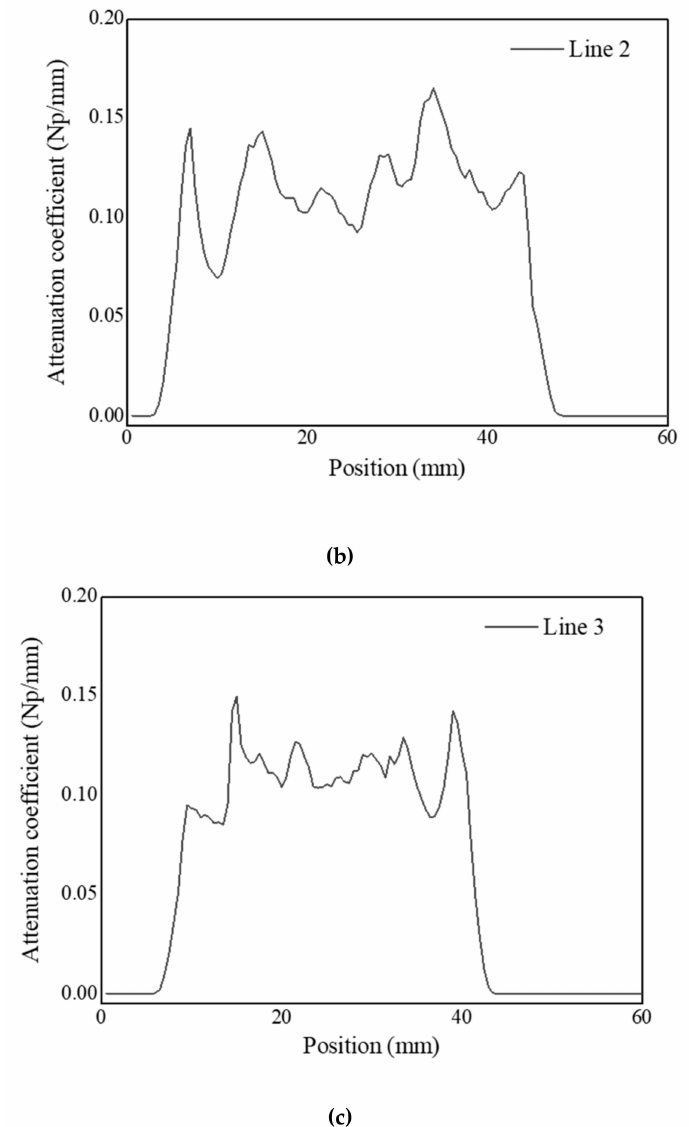
Figure 14. Attenuation coe ffi cients calculated from ultrasonic signals obtained from ( a ) Line 1, ( b ) Line 2, and ( c ) Line